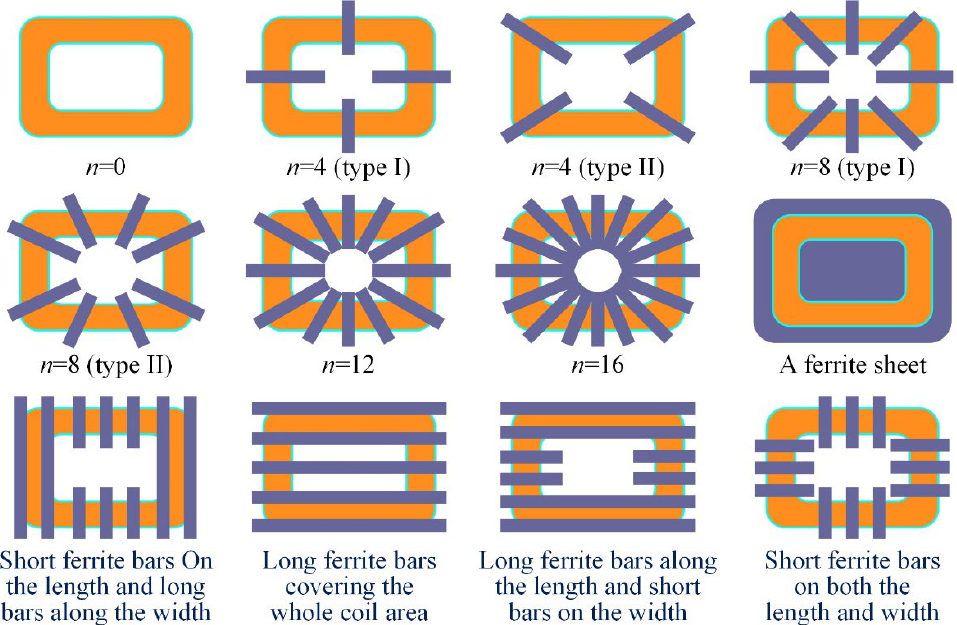
Figure 13. Different ferrite geometries for Rx coils, including a reference design (a ferrite sheet) and 11 lightweight designs.